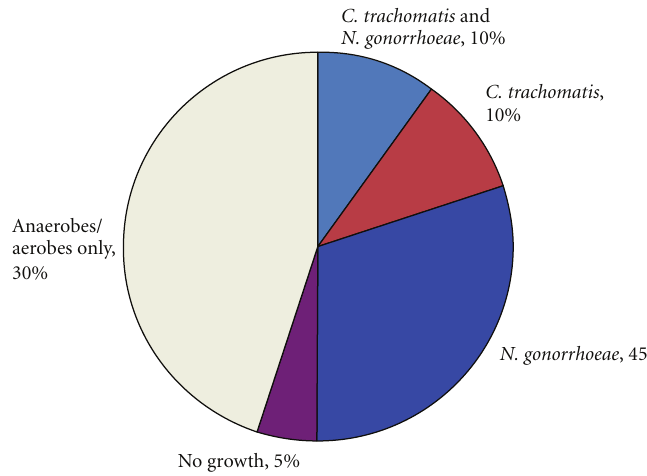
Figure 2: Microbiology of acute